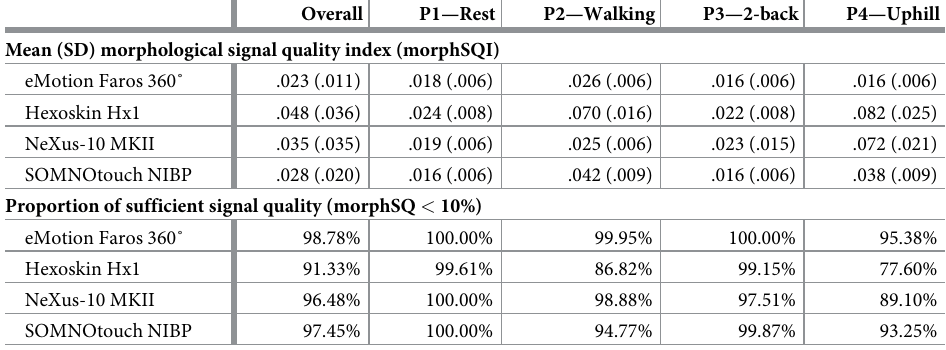
Table 3. Morphological Signal Quality Index (morphSQI) expressed as mean over all participants (average SD) and proportion of sufficient morphological signal quality (morphSQ < 10%).